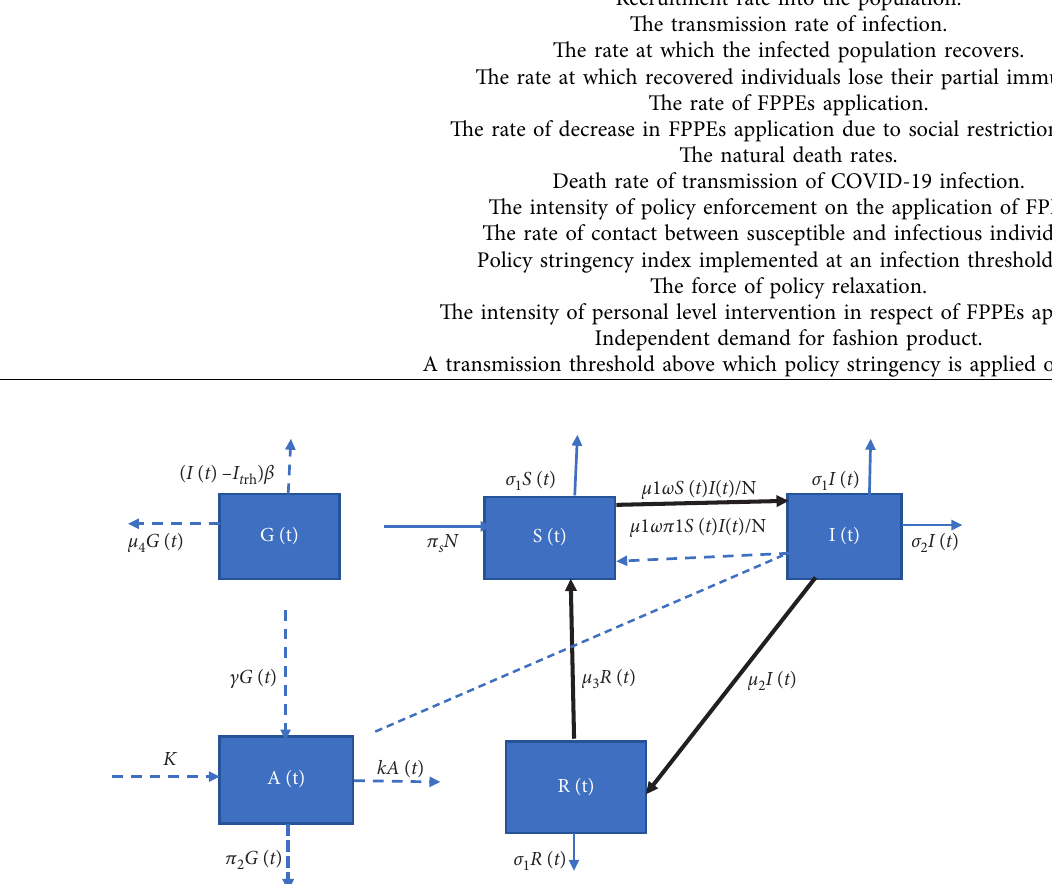
Figure 1: Depiction of the model. The gaps between the compartments indicate a flow only in the direction of the arrows. For instance, the flow from G ( t ) to A ( t ) is an inflow to A ( t ) but not an outflow to G ( t ). Due to the application of FPPEs, the transmission of infection from state S to state I will reduce at a rate π . The states (S) I, (R) A, and G are continuous functions of 1